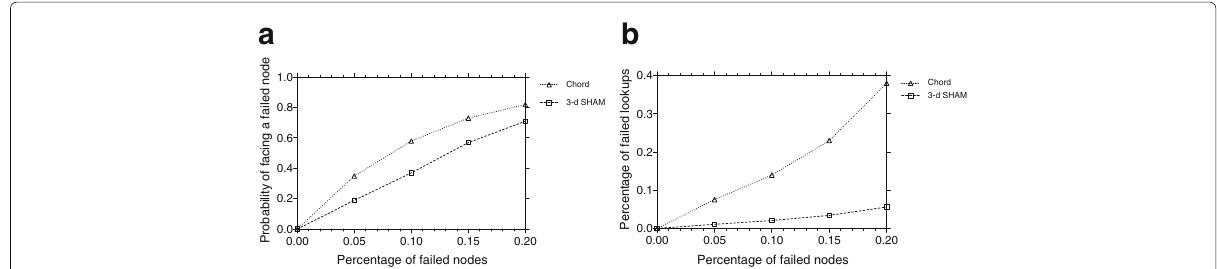
Fig. 10 Performance comparison between SHAM and Chord. a Probability that a query will encounter a failed node. b Percentage of failed